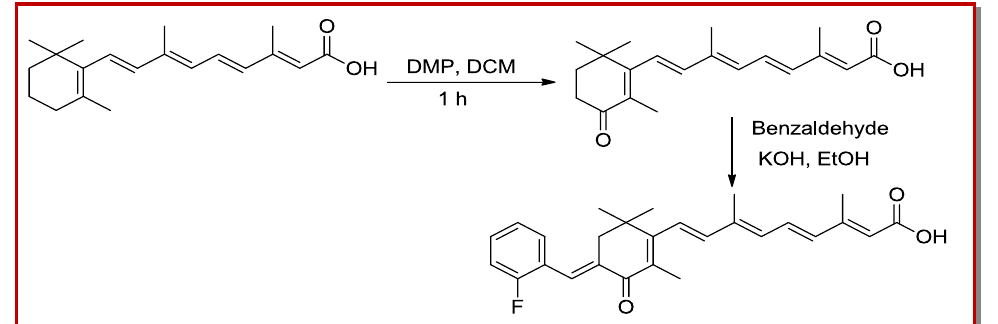
Scheme 1: Synthesis of 2-florobenzaldehyde retinoic acid